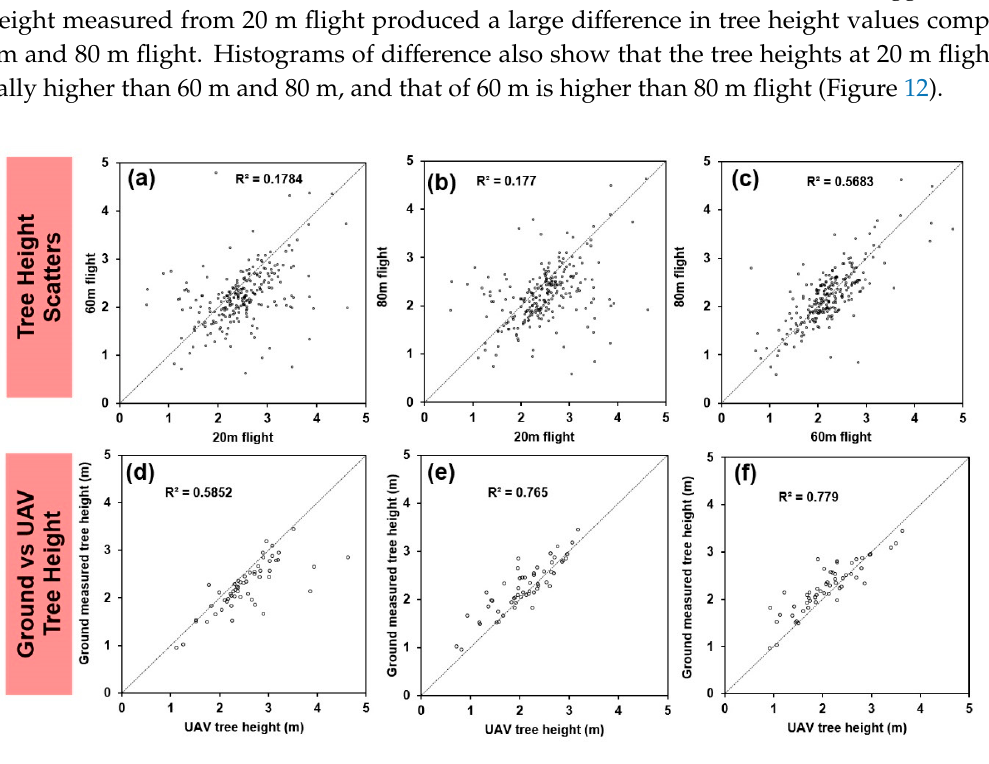
Figure 11. Scatterplot to compare tree height measured from di ff erent altitudes. Comparison between ( a ) 20 m and 60 m, ( b ) 20 and 80 m, and ( c ) 60 m and 80 m. Plots between ground measured tree height and UAV estimated tree height at flight altitude of ( d ) 20 m, ( e ) 60 m, and ( f ) 80 m.